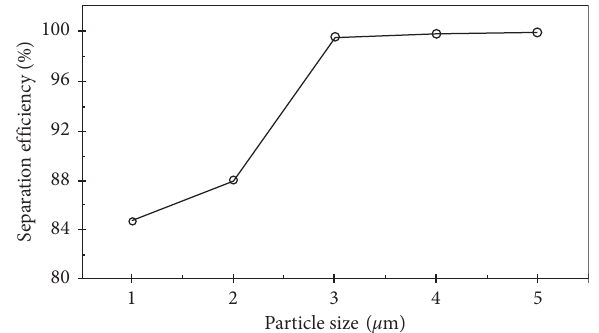
Figure 8: Particle separation efficiency as a function of particle diameter.